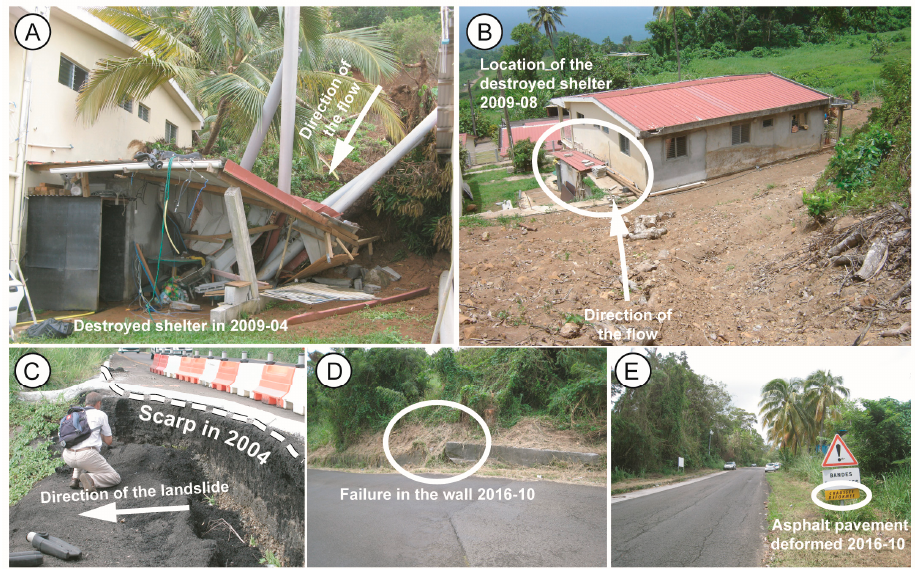
Figure 3. ( A ) Shallow landslide in Morne Congo occurring in April 2009; ( B ) slope of the shallow landslide (Figure 3A) after works in August 2009; ( C ) Morne—Figue landslide in 2004 after reactivation of the upper part; ( D ) failure in a wall downstream of the Morne—Figue landslide (2016); ( E ) municipality road deformed by the Morne—Figue landslide (2016).